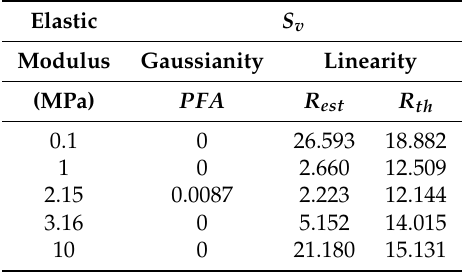
Table 6. Results of Gaussianity and the linearity test for the S v